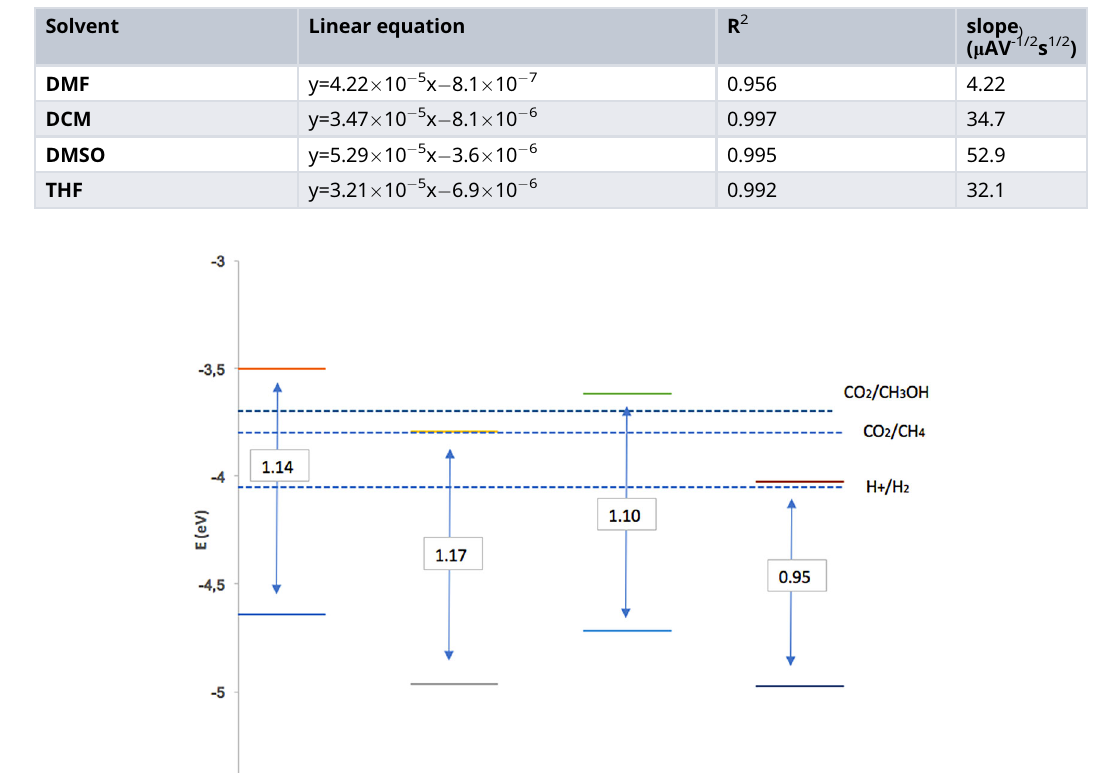
Table 3. Fitting parameters for I p versus v 1/2 plot to each solvent.